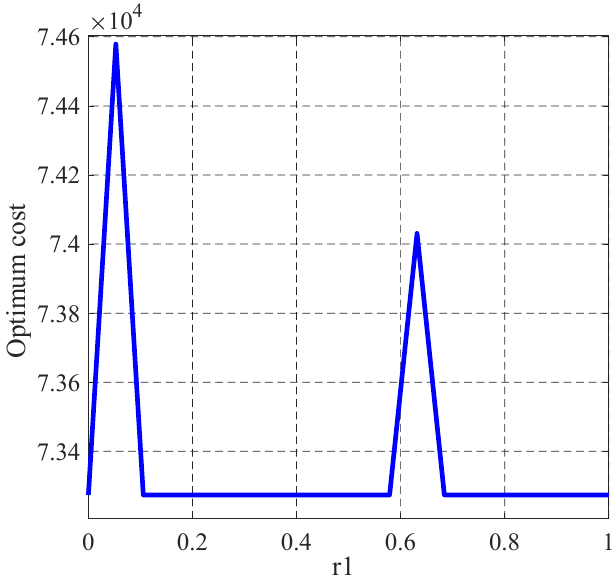
Figure 19. Variation of the optimum solution versus the parameter ( 𝑟 (cid:2869) (cid:4667) .